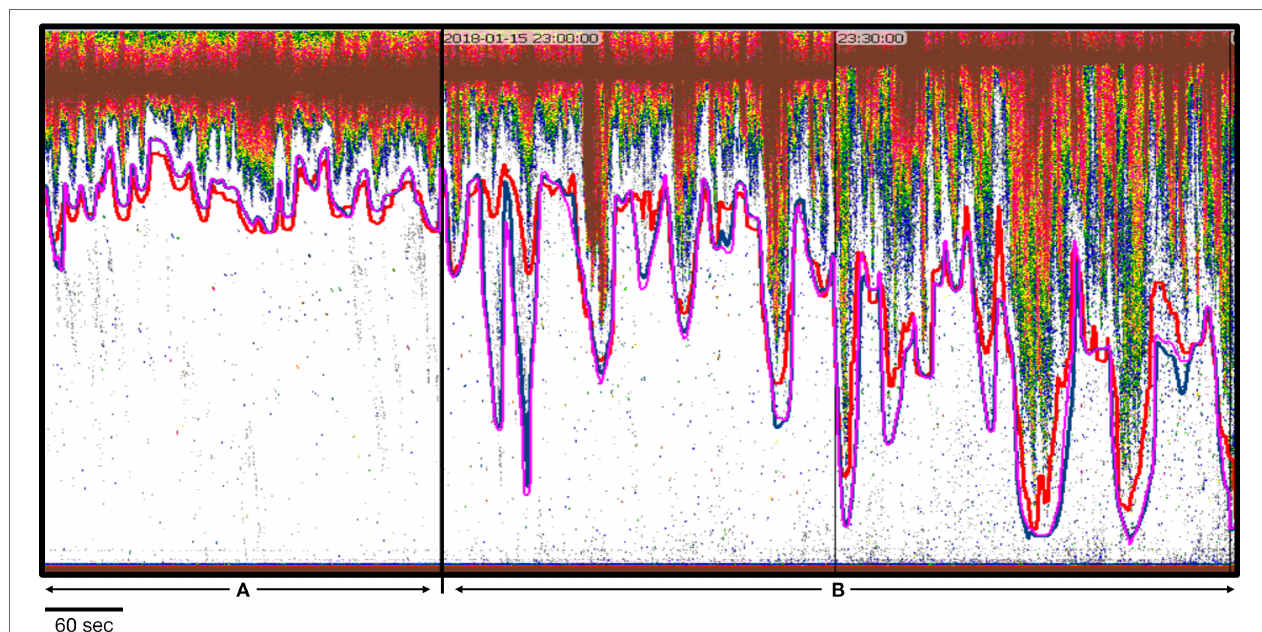
FIGURE 4 | Entrained-air lines as defined by Echofilter (Upfacing@100ep: pink; Bifacing@100ep: blue) and by Echoview (red). (A) A 5-minute data collection period during which entrained air does not penetrate deeply into the water. The Echoview line is further from the entrained air than the Echofilter lines, leaving greater amounts of white space and thereby unnecessarily excluding more water column from analyses. (B) Two 5-minute data collection periods during which the returns from entrained air are more depth dynamic. The Echofilter placement of the entrained-air lines more closely reflect the penetration of the entrained air in terms of depth and width. In the horizontal dimension, the Echofilter lines are appropriately placed further from the entrained air in the particularly steep sections. Note that Echofilter entrained-air lines as defined by each model (Bifacing@100ep and Upfacing@100ep) are essentially equivalent although not identical. Data: stationary data with echosounder in upfacing orientation, recorded for 5 minutes every half hour at the Minas Passage site.